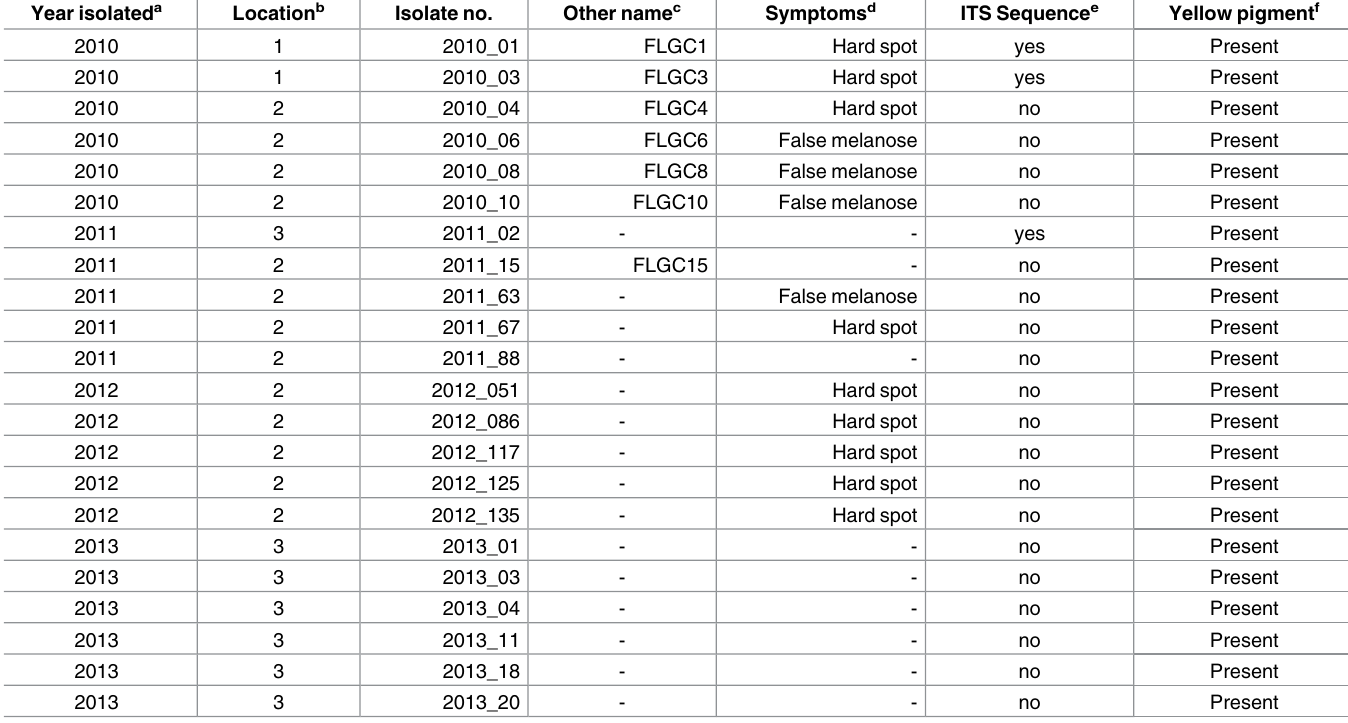
Under normal circumstances an EC50 approach (the fungicide concertation required to reduce growth by 50% of the control) would be used to evaluate in vitro fungicide sensitivity of the fungus of interest. In this case, since the concentrations tested resulted either in no effect Table 1. List of Phyllosticta citricarpa isolates obtained from Citrus sinensis fruits in Florida and their characteristic included in this study. Year isolated a Location b Isolate